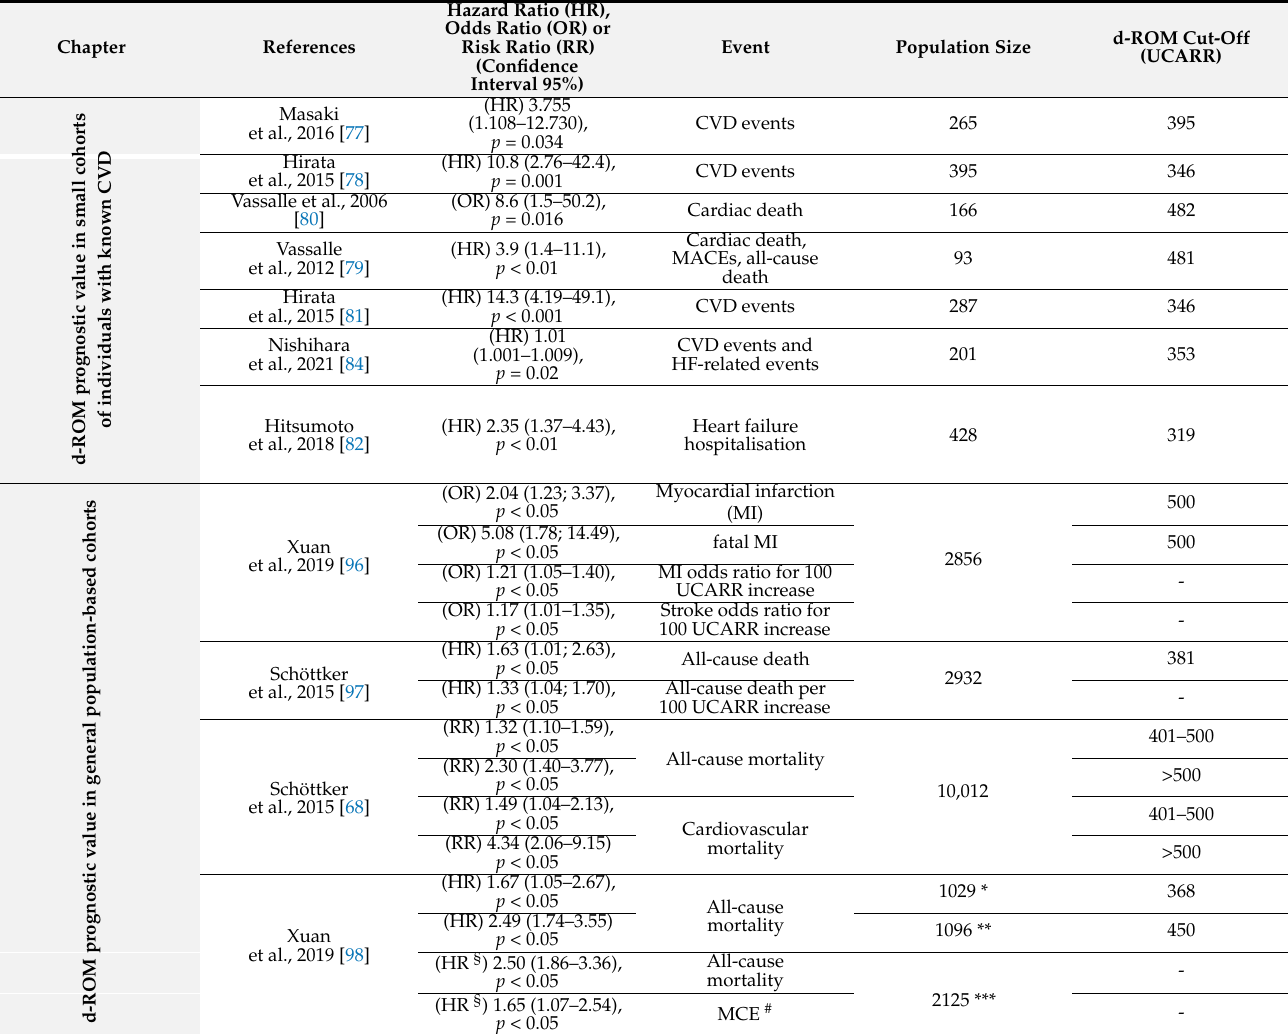
Table 3. Summary of the studies analysing the association between d-ROM values and the risk of CVD events and